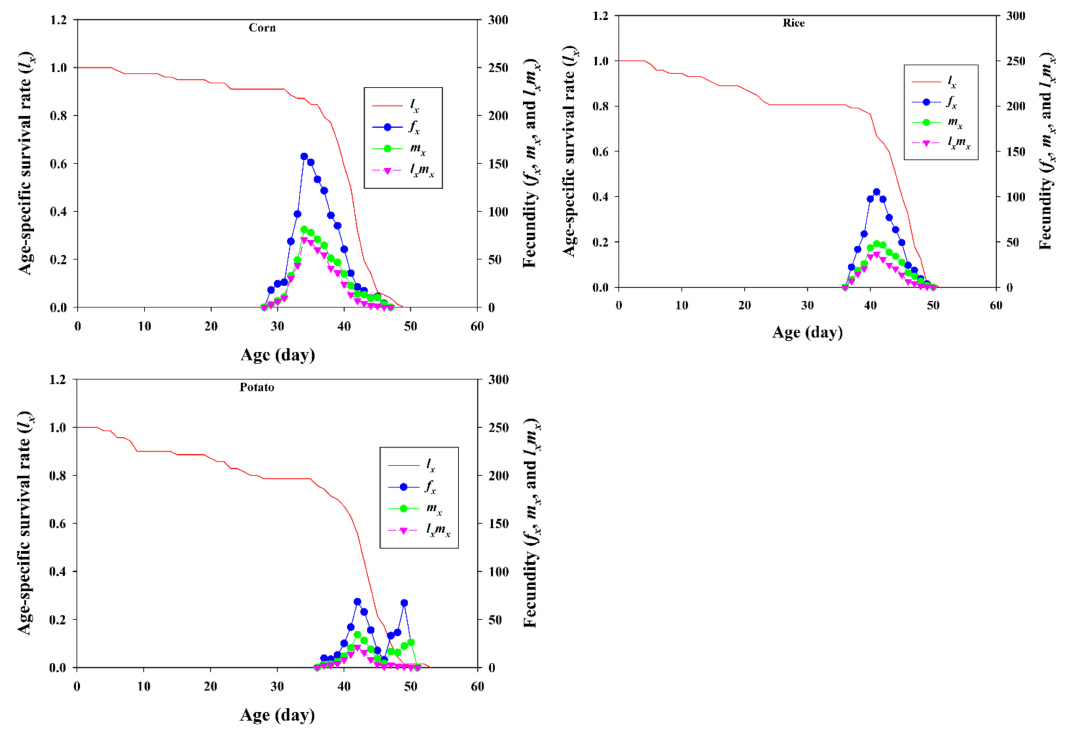
Figure 3. Age-specific survival rate ( l x ), female age-specific fecundity ( f x ), age-specific fecundity ( m x ), and age-specific maternity ( l x m x ) of Spodoptera frugiperda fed on corn, rice, and potato.